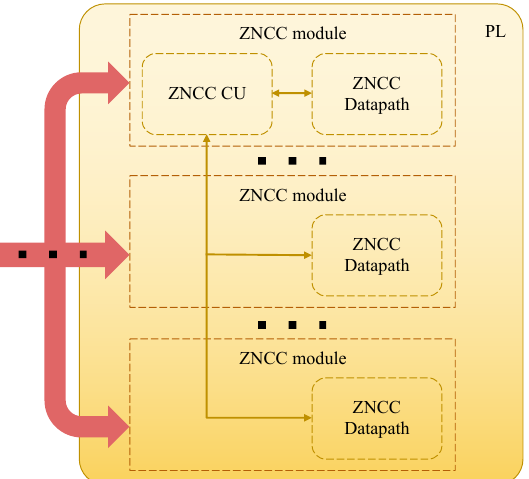
Figure 3. An illustration of how several ZNCC modules perform parallel processing, taking advan- tage of the capabilities of the PL. Each ZNCC module requires a datapath to perform operations simultaneously on different sets of input data, coordinated by a common control unit that oversees the execution of tasks following the SIMD parallel